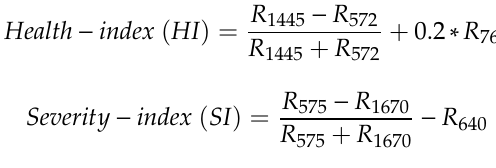
Table 4. Validation results of different SCR detection models using support vector machine-based 10- fold cross validation.